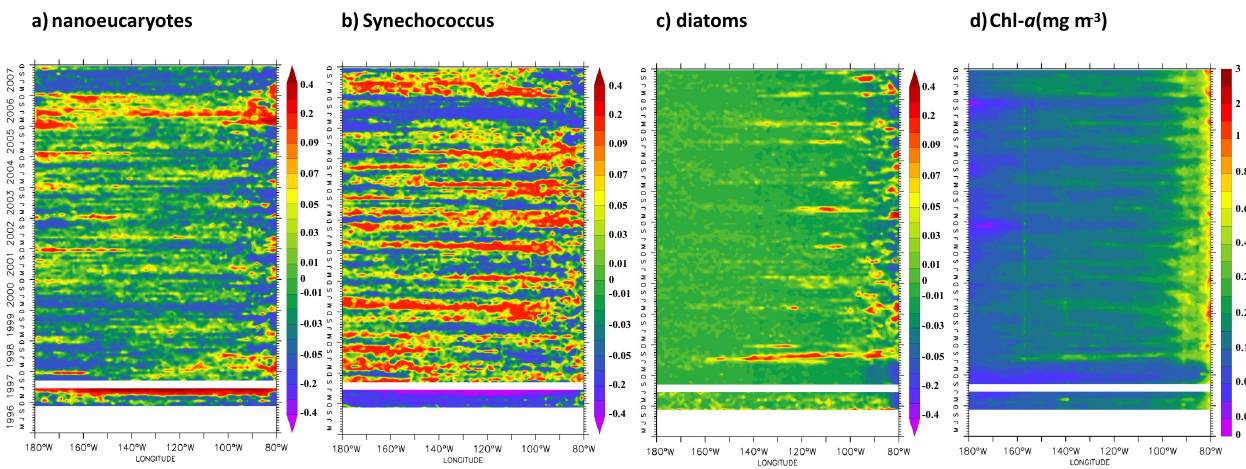
Fig. 6. Longitude-time plots of the (a) nanoeucaryotes, (b) Synechococcus, and (c) diatom dominance anomaly and (d) absolute satellite chlorophyll- a (Chl- a ) using OCTS-SeaWiFS datasets in the Equatorial Pacific region (10 ◦ N–10 ◦ S) over 1996–2007. See Fig. 5 for details of PFT dominance